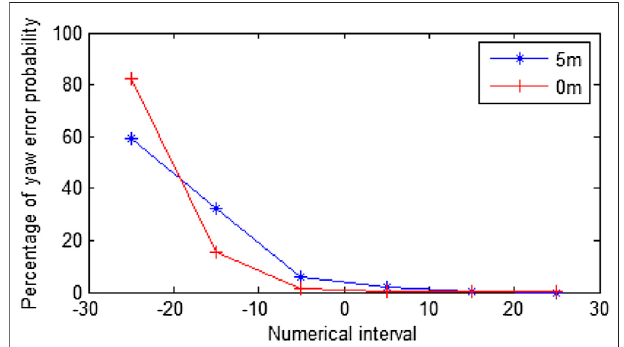
FIGURE 6 | Percentage of yaw error at 5 m distance and 0 m distance from the wind measuring instrument.